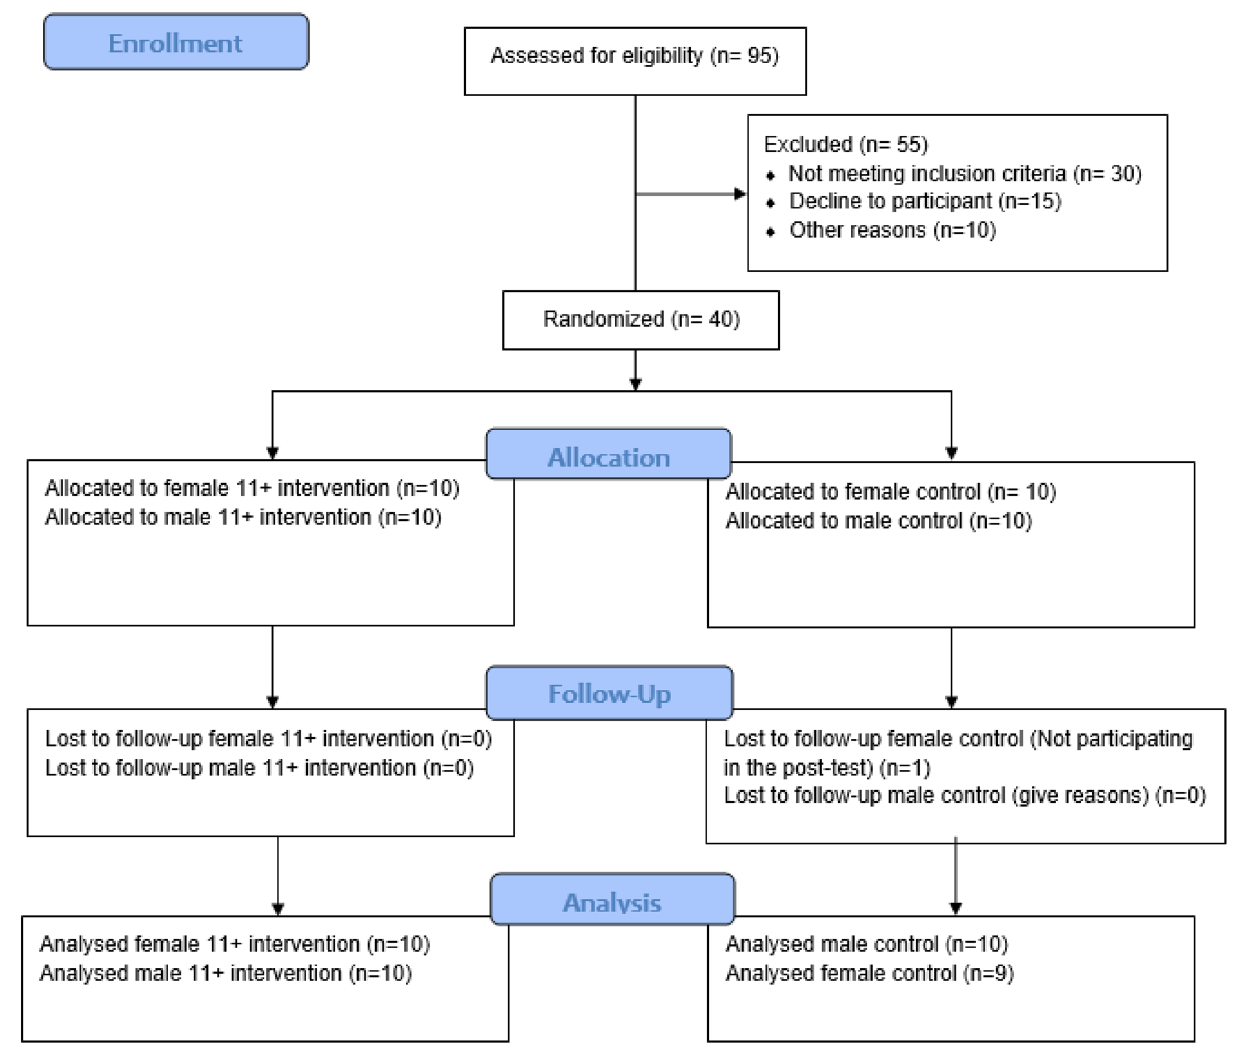
Figure 1. Consort flow